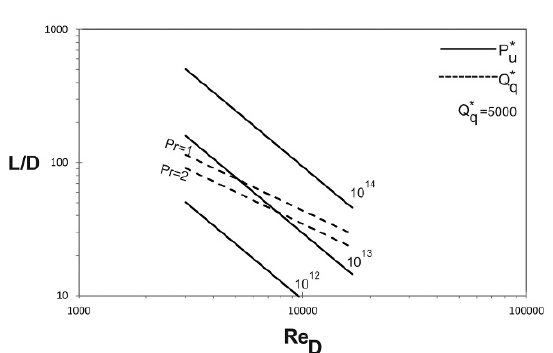
Figure 10. Influence of the Prandtl number on the variation of L/D group with the Reynolds number (turbulent regime and prescribed wall temperature boundary)